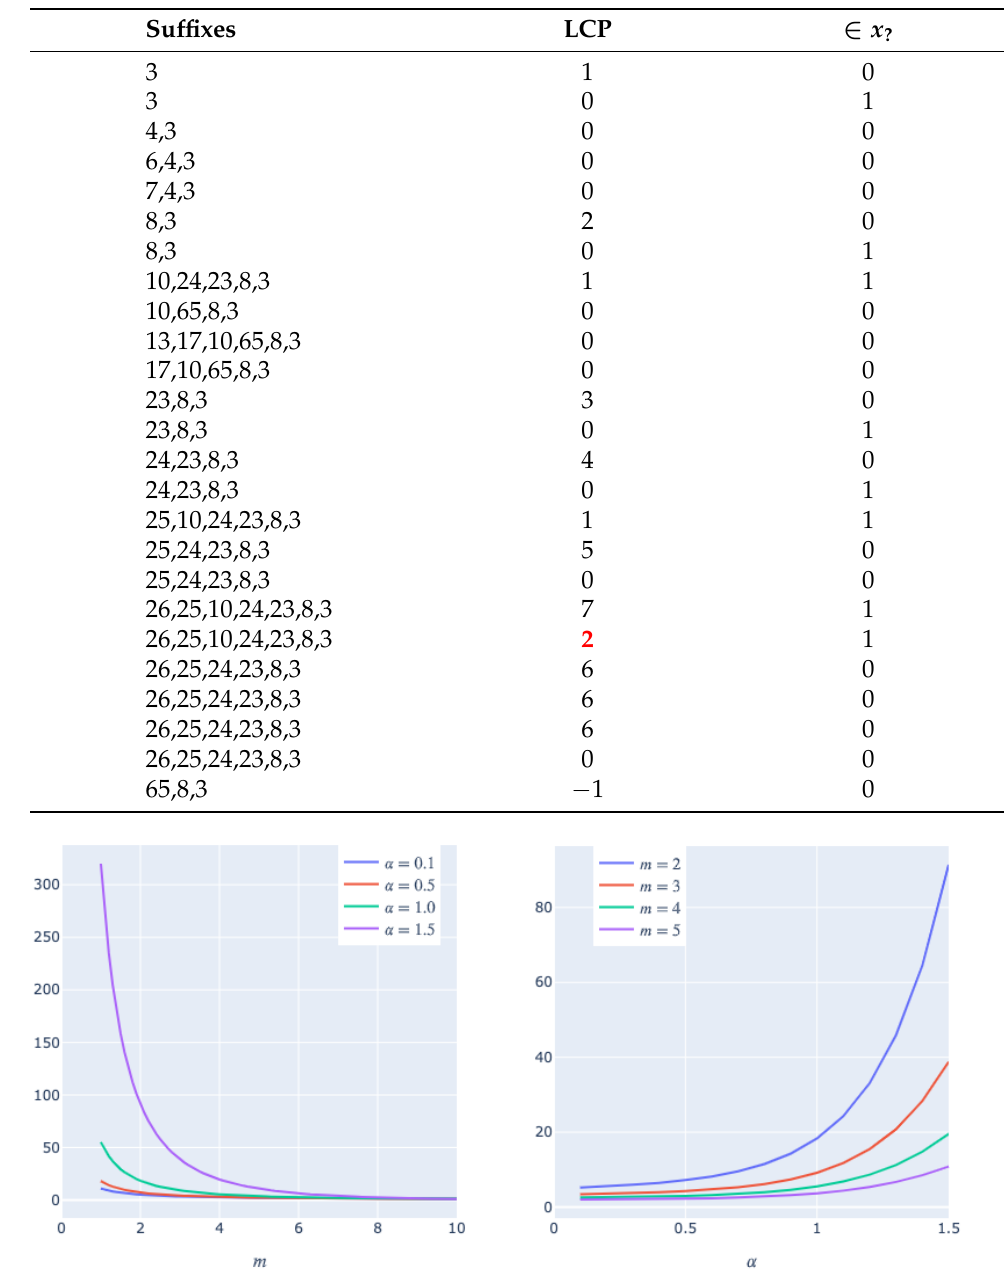
Figure 10. Transition of γ ( 10, α ) / γ ( m , α ) when m moves ( left ) and α moves ( right